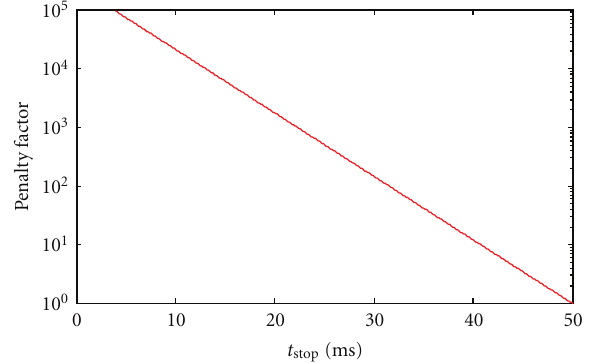
Figure 8: Penalty factor for the cost function in (4) for simulations stopped prematurely. An intended stop time of 50 ms was assumed.